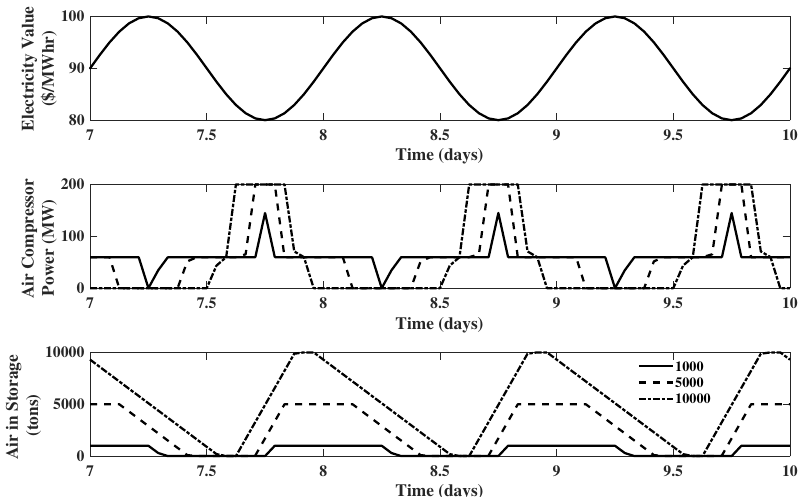
Figure 8. Closed-loop simulation of EMPC using a 24 h prediction horizon for Example 6.